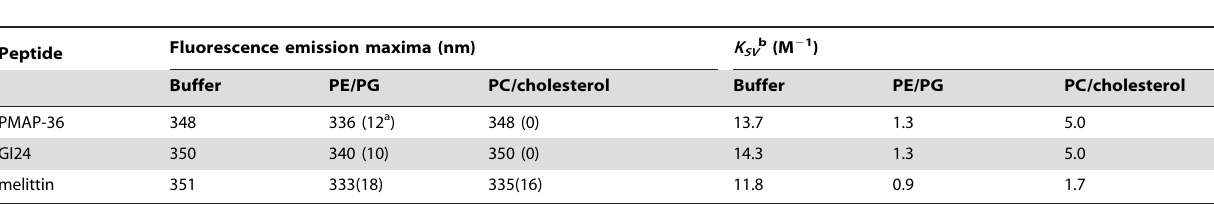
Table 3. Fluorescence spectroscopy parameters measured for the peptides in the presence and absence of PE/PG and PC/ cholesterol vesicles.